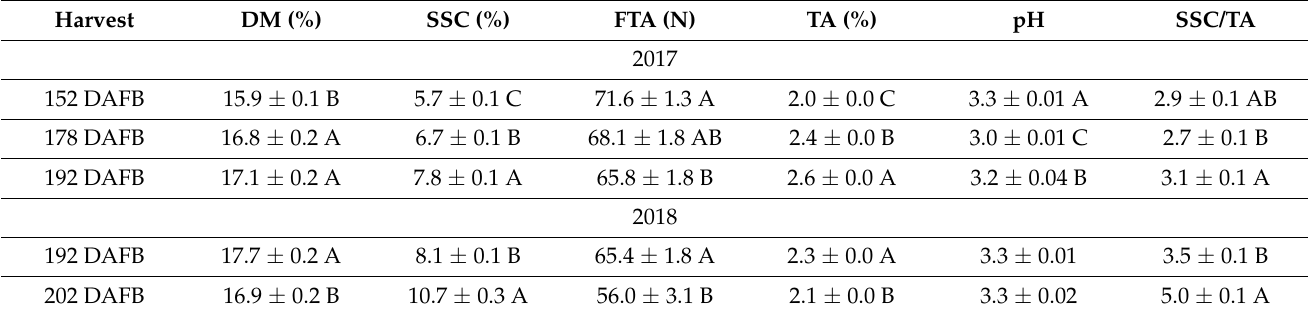
Table 1. Ripening indices (mean ± SE, n = 5) of kiwifruit harvested for storage in 2017 and 2018. Harvest